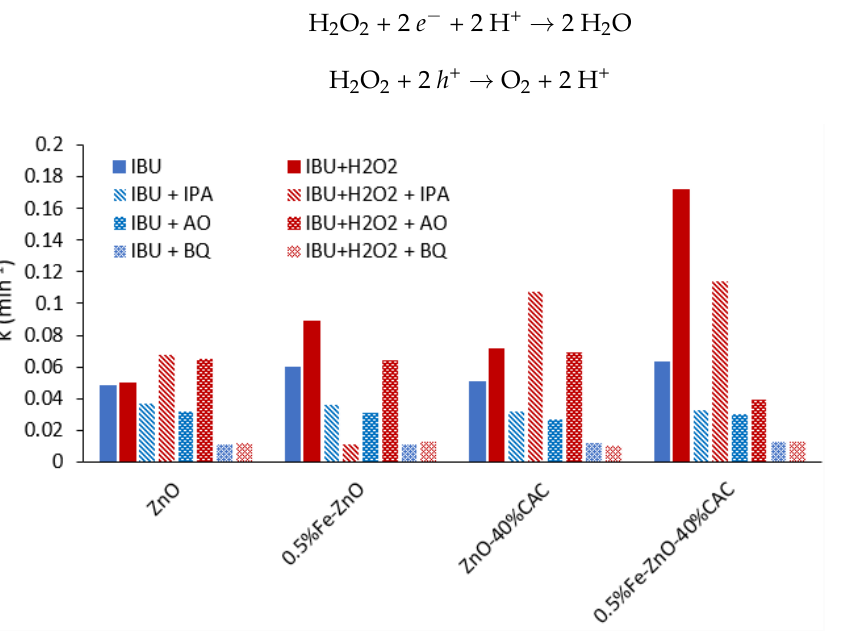
Figure 10. Effect of scavengers on photocatalytic degradation using ZnO, 0.5%Fe-ZnO, ZnO-40%CAC and 0.5%Fe-ZnO-40%CAC on the first-order kinetic rate constant in the presence of isopropanol (IPA) and ammonium oxalate (AO) and benzoquinone (BQ).